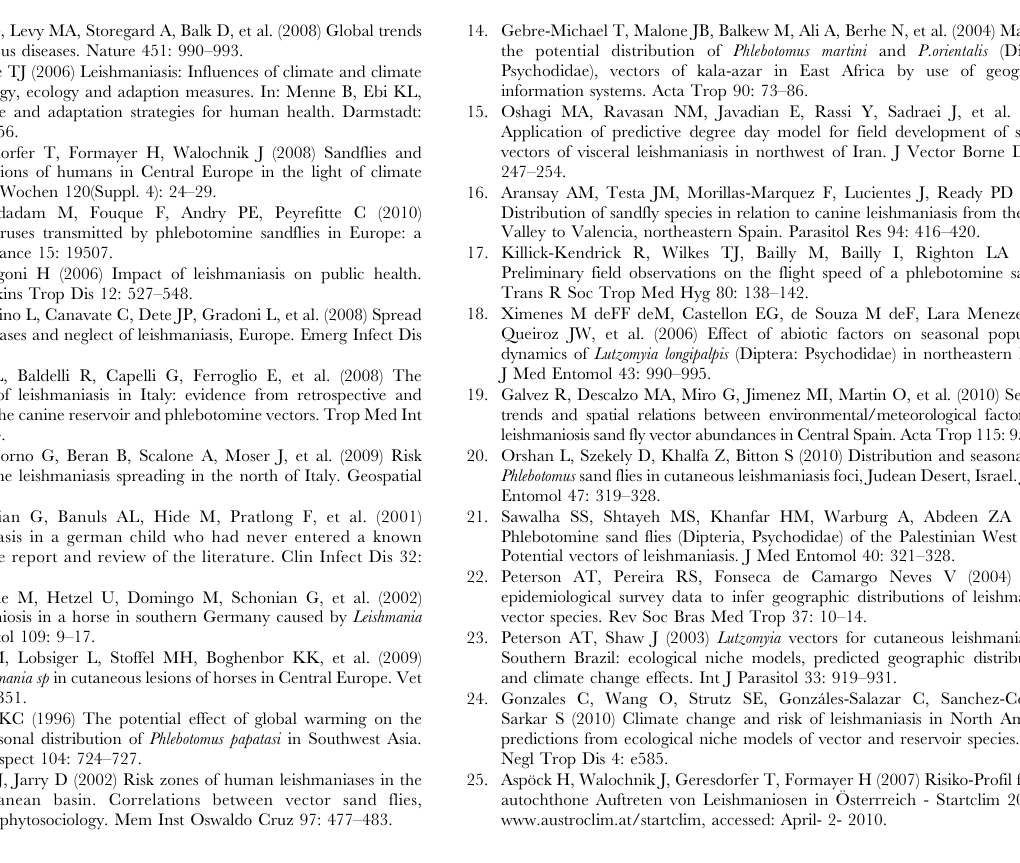
from 0 (unfavourable conditions) to 1 (perfect conditions). Projections refer to the B1 scenario. (TIF) Figure S2 Least-cost paths for Phlebotomus species. The detected pathways indicate direction of spread in the 21 st century. Spatio- temporal varying climatic suitability and wind speed included in the cost surface that must be crossed by species in the 21 st century refer to the B1 scenario. (TIF) Table S1 Current and projected climatic suitability for Phlebot- omus species in Central Europe. Noted are mean values and standard deviation in brackets. Projections refer to the B1